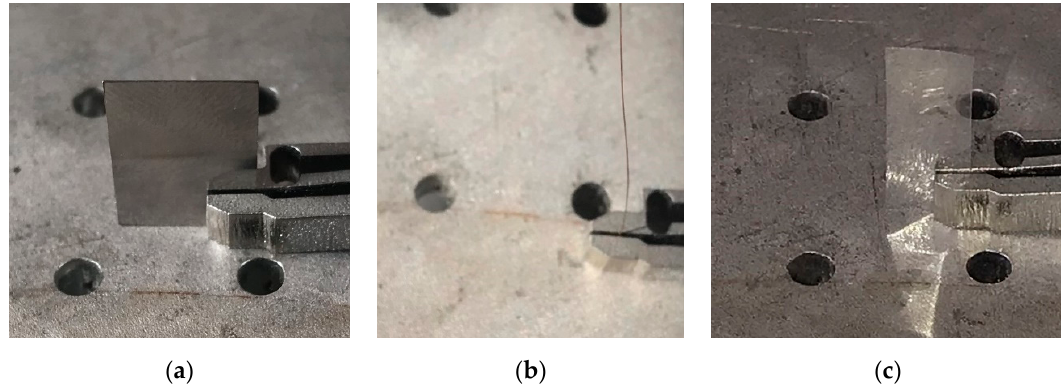
Figure 13. Grasping manipulation for different shaped and sizes of micro-objects (from left to right):